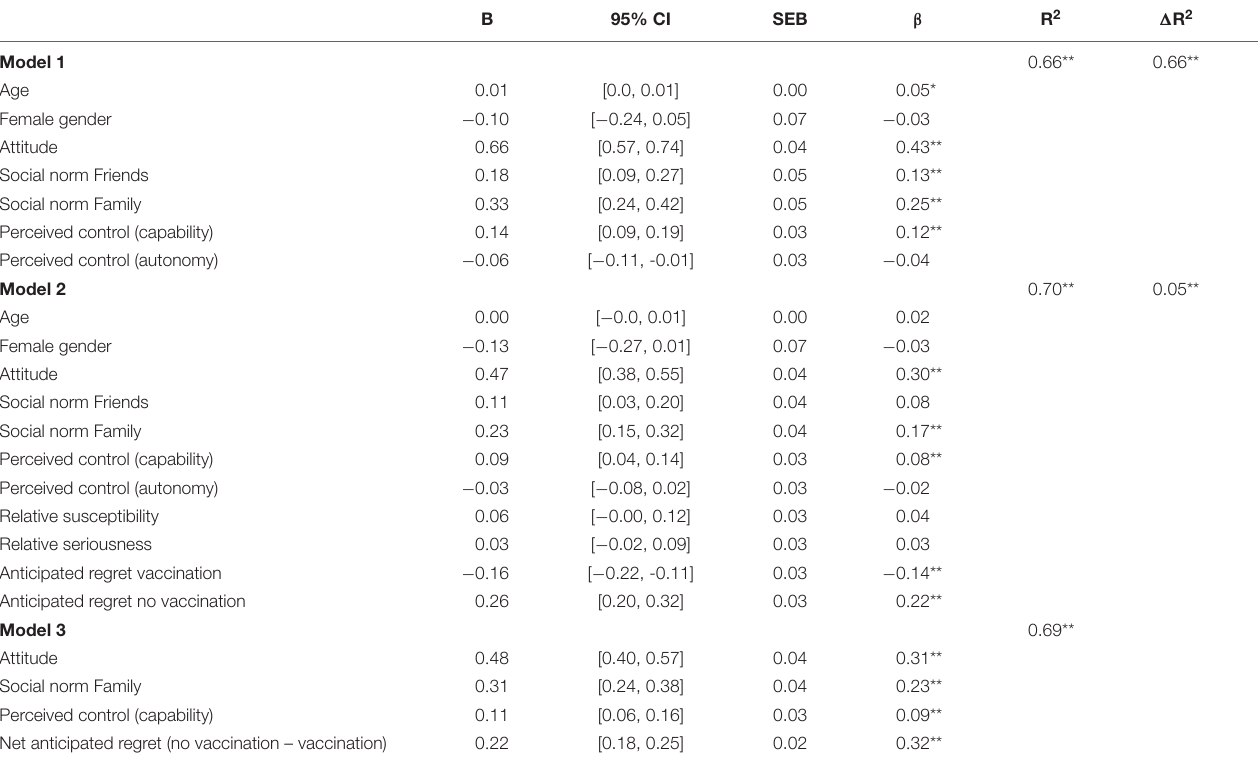
TABLE 3 | Two-step hierarchical regression analysis (Model 1 and 2) and separate regression containing significant predictors (Model 3) of intention to get